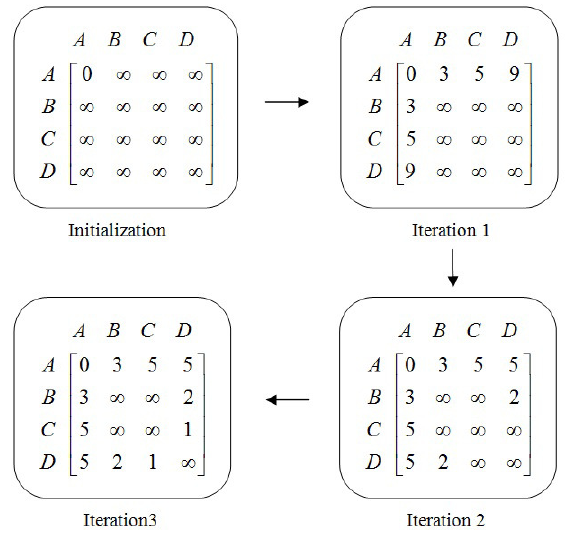
Figure 3. The solution procedure of Dijsktra’s